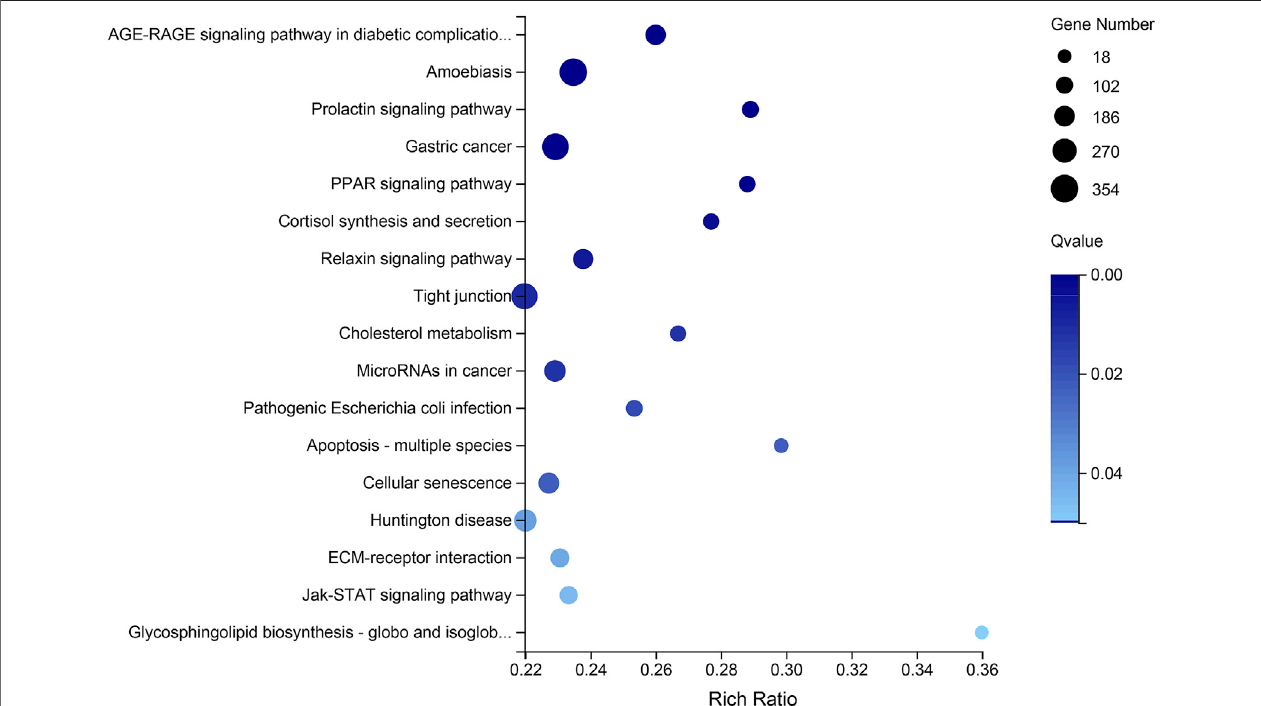
FIGURE 5 | KEGG pathway enrichment based on the overlapping differentially expressed genes (DEGs) of the testis-vs-ovary